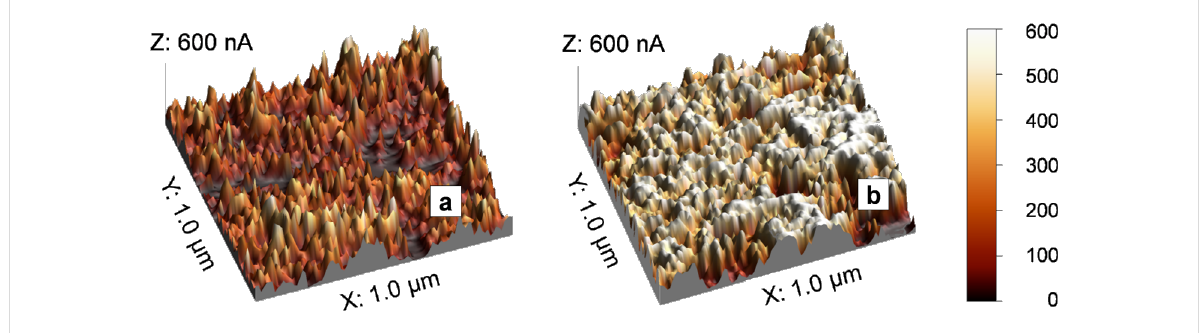
Figure 17: Locally resolved current maps of (a) coated and (b) sprayed gas diffusion electrode measured with the conductive AFM. The scan area is 1 μ m × 1 μ m. Reprinted with permission from [12]. Copyright 2014 Elsevier.